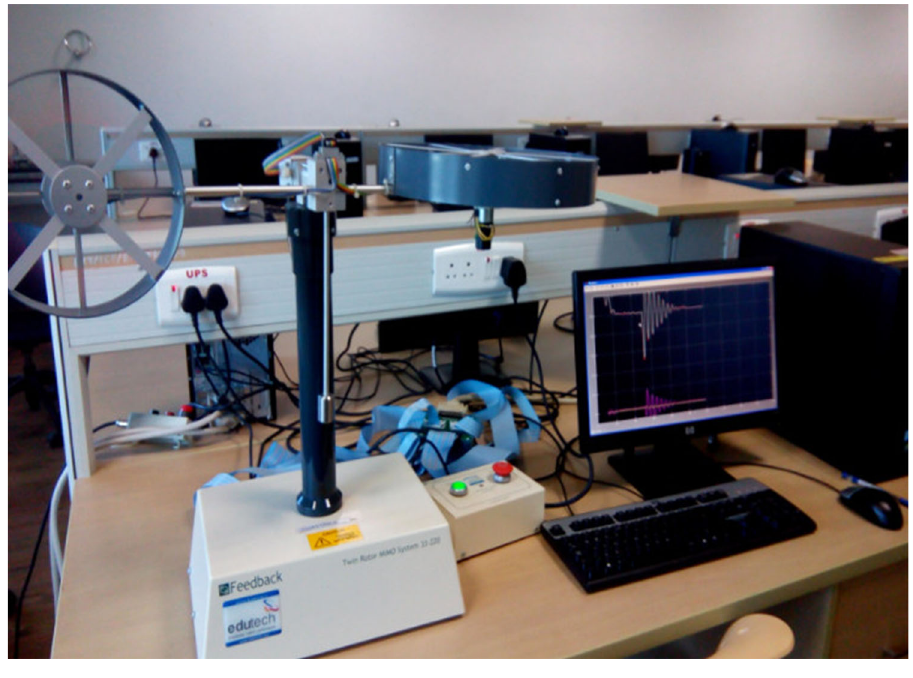
Figure 3. An experimental setup was used to demonstrate the proposed